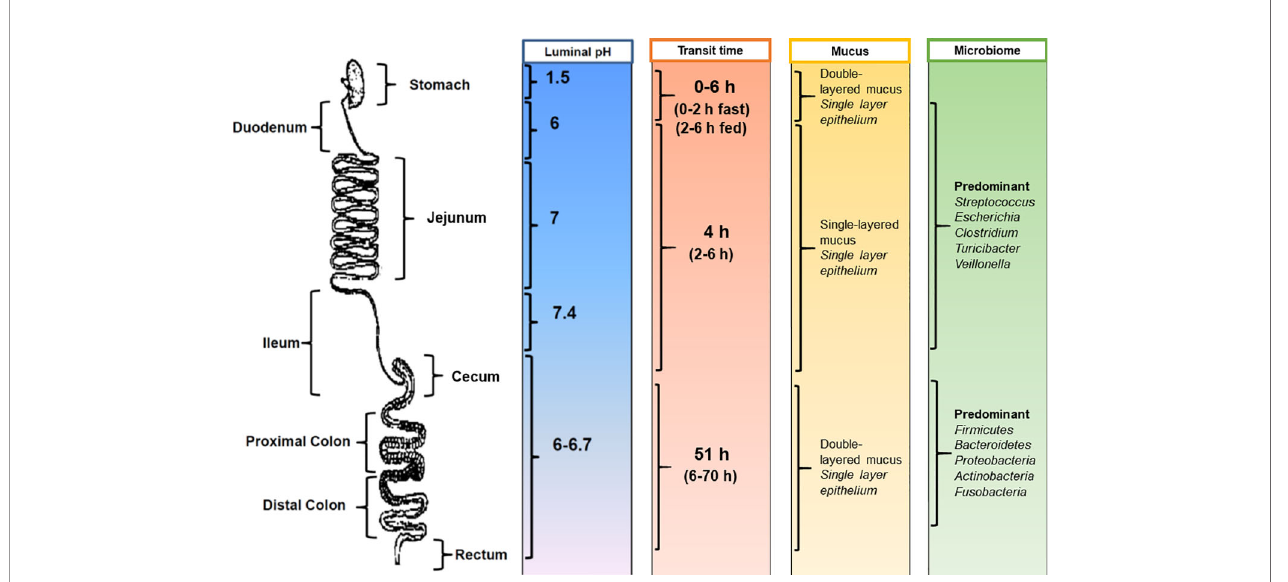
FIGURE 1 | Physiological factors in the gastrointestinal tract that in fl uence oral drug delivery. [Adapted from (Hua et al.,